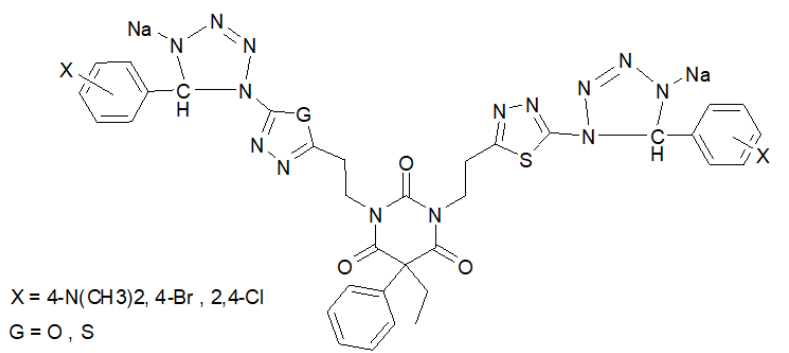
Fig. 5 . Structure of barbituric acid derivatives containing 1,2,3,4-tetrazoline moiety